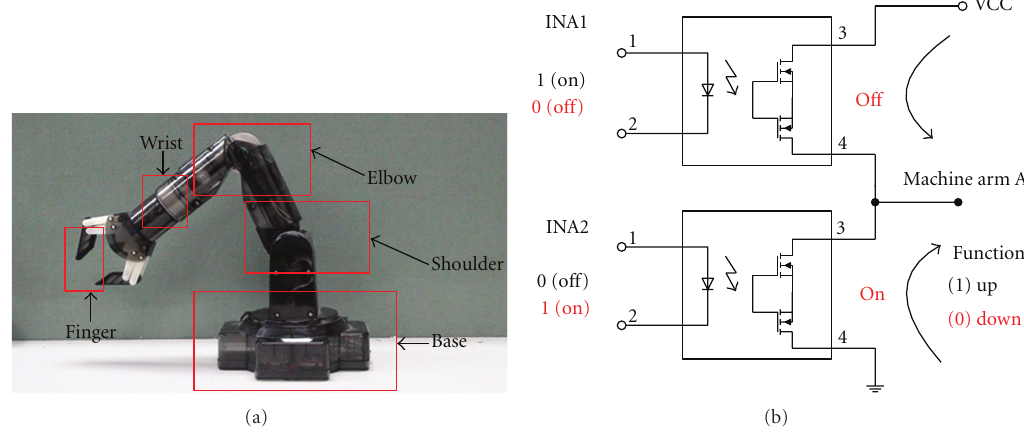
Figure 4: (a) A five-axis machine arm manufactured by I-Chung Computer Co. Ltd. (b) The machine arm’s driving circuits composed of two